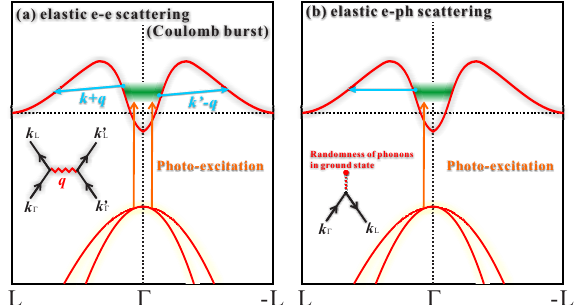
Figure 8. A schematic explanation of ( a ) elastic e-e scattering (Coulomb burst) and ( b ) elastic e-phonon (ph) scattering is shown. Adapted with the permission from [12], copyright Journal of the Physical Society of Japan,